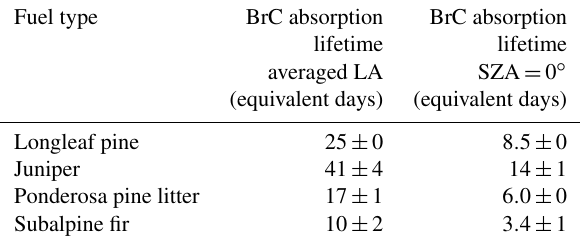
Table 3. Lifetimes for the loss of the measured integrated ab- sorbance from 300 to 700nm. The results are expressed in equiv- alent days of solar exposure to either time-averaged solar flux in Los Angeles (middle column) or peak solar flux at SZA = 0 ◦ (right column). The lifetimes were calculated from the transmission spec- tra measured for particles on PTFE filters. The irradiation was done in the condensed phase on the filter for all